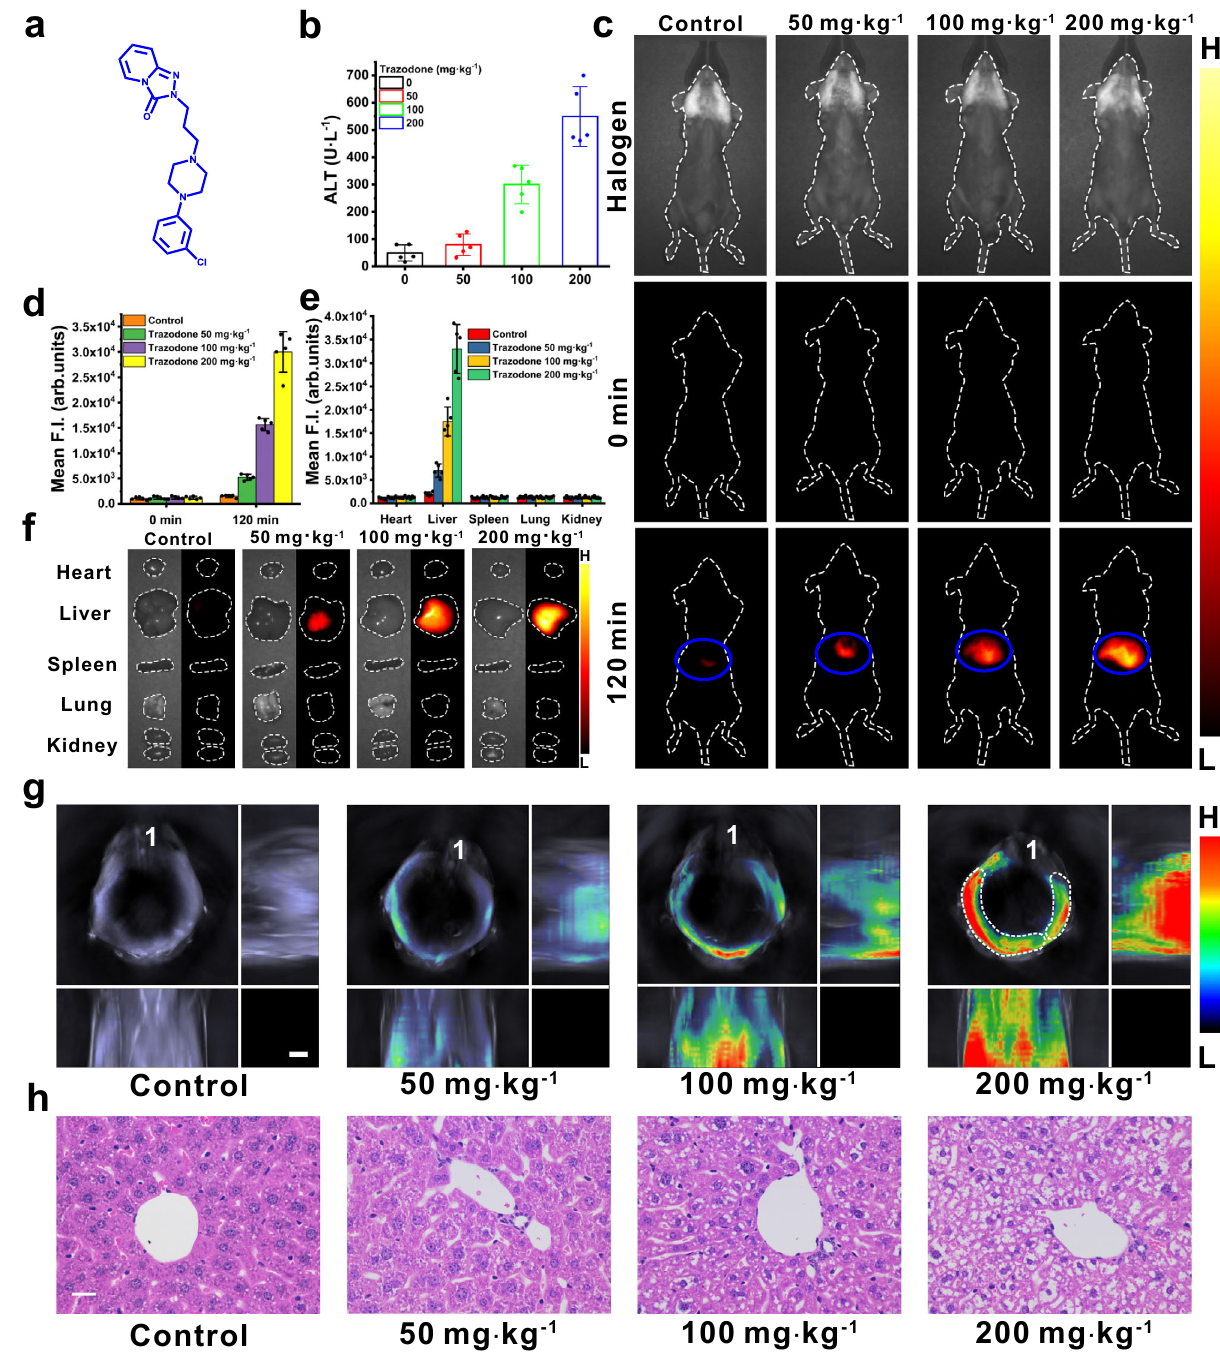
Fig. 5 Application of nanoprobe BTPE-NO 2 @F127 in trazodone-induced liver injury mouse model. a Molecular structure of trazodone. b Serum levels for the enzyme ALT of different groups ( n = 5 animals per group). c Typical photographs under halogen light (serving as bright- fi eld images) and NIR-II fl uorescence images for the control group (mice administered with saline), and the mice pretreated with 50 mg kg − 1 , 100 mg kg − 1 and 200 mg kg − 1 trazodone at 0 min or at 120 min after i.v. injection of the nanoprobe BTPE-NO 2 @F127. Blue circle: liver region. Color bar: L: 6.0 × 10 2 , H: 6.0 × 10 4 (arb. units). d Mean NIR-II fl uorescence intensities at ROI (circled with blue curve) for liver site of the mice in c . n = 5 animals per group. e Mean NIR-II fl uorescence intensities of the major organs corresponding to NIR-II fl uorescent images in f . n = 5 animals per group. f Representative ex vivo NIR-II fl uorescent images for the dissected organs (heart, liver, spleen, lung, and kidney) from different groups at 120 min after i.v. injection of BTPE-NO Color bar: L: 6.0 × 10 2 , H: 6.0 × 10 4 (arb. units). g Typical 3D MSOT images for the mice at 120 min after BTPE-NO 2 @F127 injection. White dotted circle: liver region. Scale bar: 3 mm. h H&E stained liver sections of different groups ( n = 5 animals per group. The experiments were repeated independently three times with similar results). Color bar: L: 6.1 × 10 1 , H: 4.1 × 10 3 (arb. units). Scale bar: 20 μ m. Data with error bars are all presented as mean ± SD. F.I. fl uorescence intensity, ALT alanine